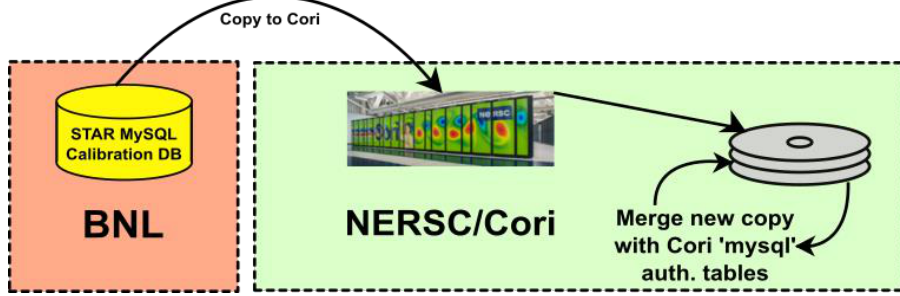
Figure 3. Diagram illustrating the STAR MySQL Calibration DB copied to Cori. The transfer is secure as it is stripped of account/password information, we then merge the MetaData payload with Cori ’s ‘mysql’ authentication/authorization table